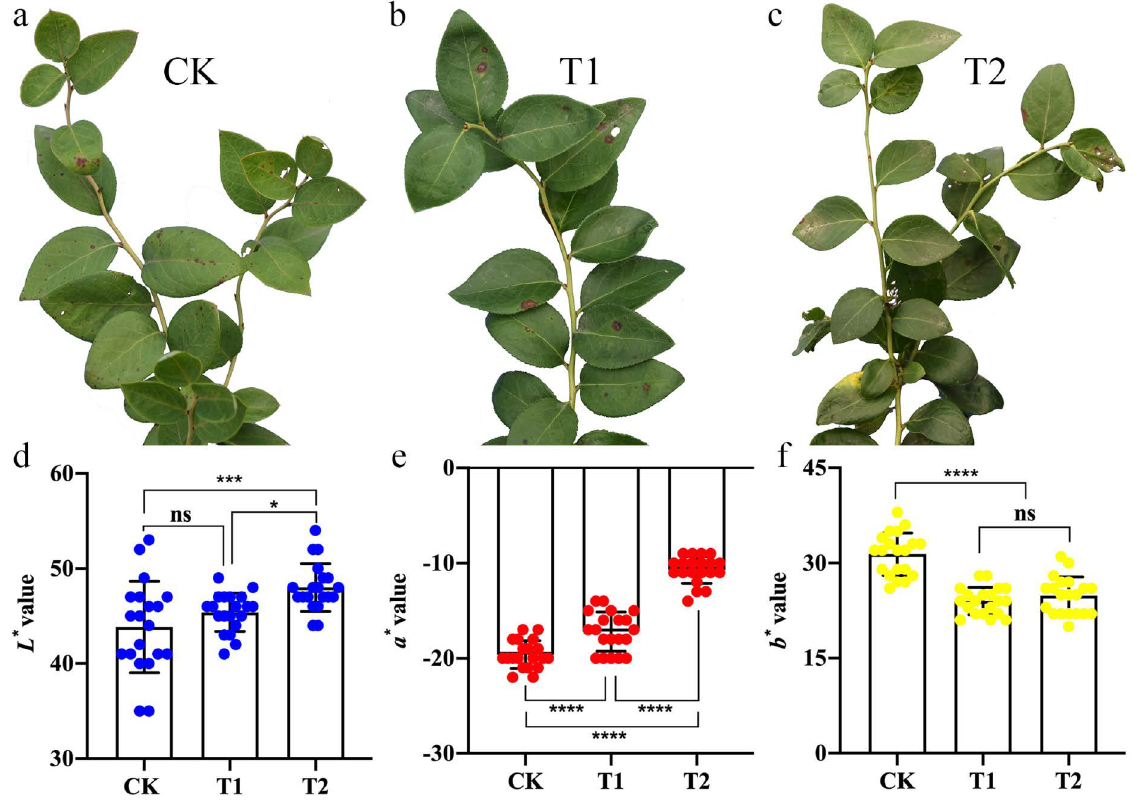
Figure 1. Phenotypic observations ( a – c ) and colour parameters ( d – f ) of blueberry leaves. *, *** and **** represents a significant correlation at the 0.05, 0.001 and 0.0001 level, respectively. The ns represents no significant